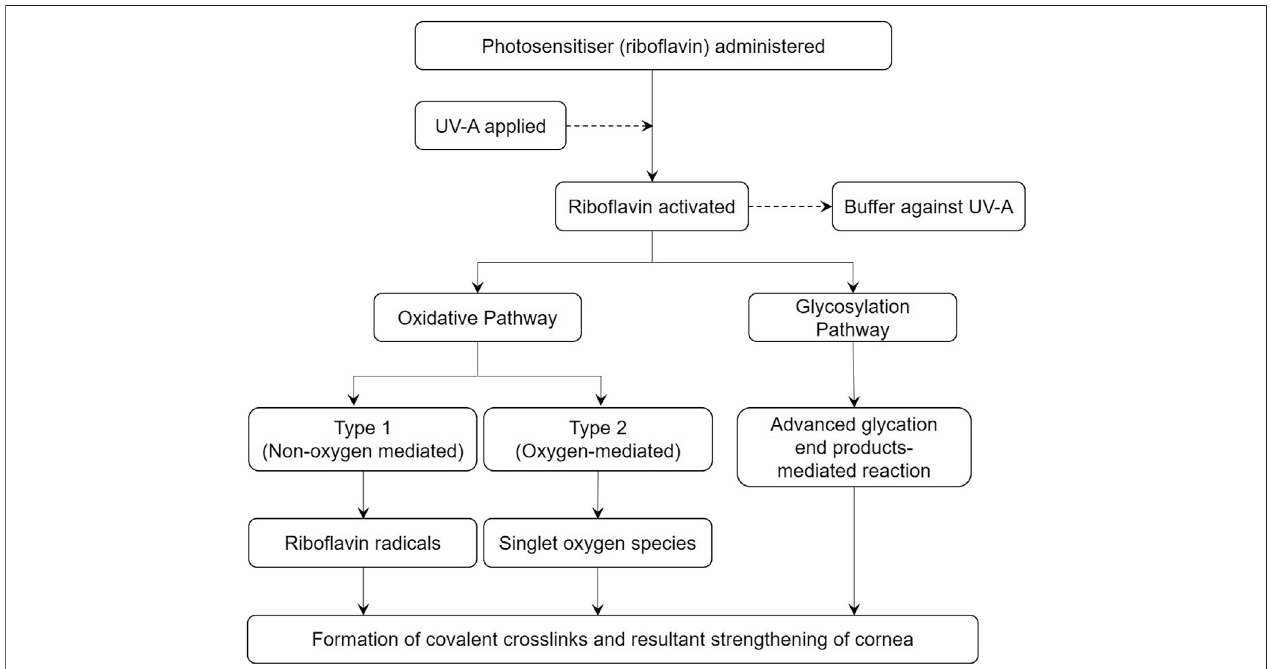
FIGURE 1 | Proposed mechanisms of action of ribo fl